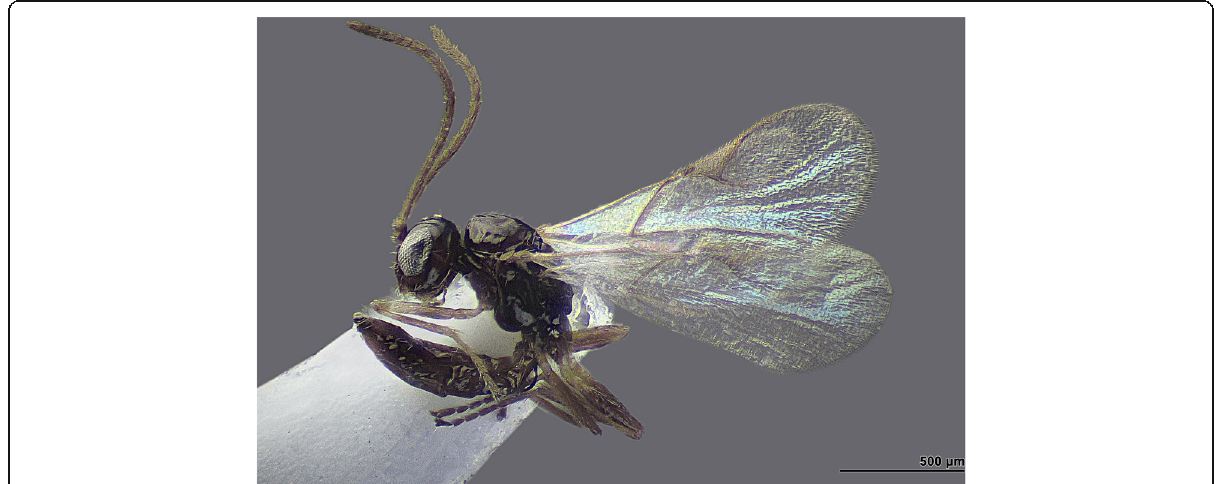
Fig. 1 Diaeretus leucopterus (Haliday), female, lateral aspect of habitus